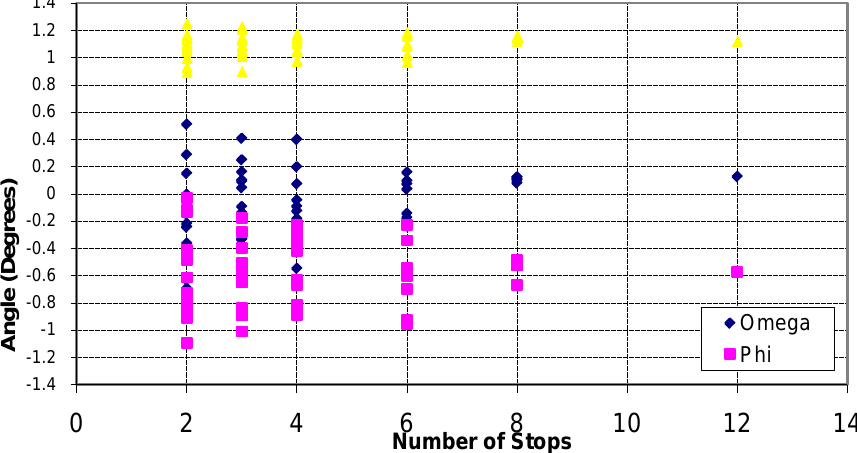
Figure 10. Field Test Results of the DAS showing precision of calculated orientation angles vs. number of device stops for different symmetrical configurations of the device stops; the chart shows the asymptotic nature of the precision curve as the number of device stops approaches 10